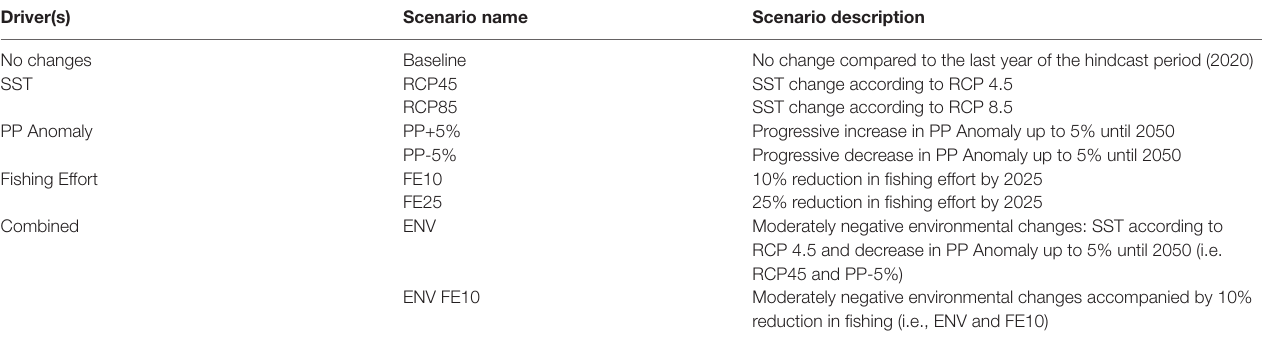
TABLE 2 | Scenarios applied for the future